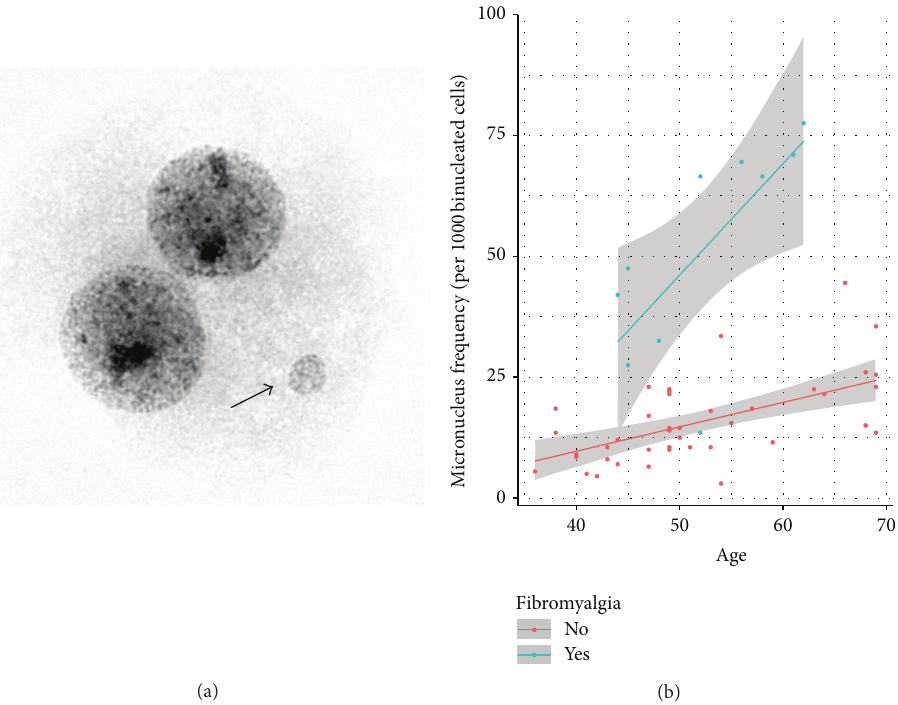
Figure 1: Increased frequency of micronuclei (MN) in women with FM. (a) A representative cell blocked at the cytokinesis phase of mitosis is shown. Karyokinesis has been completed, resulting in 2 daughter binucleates having a single MN (arrow). (b) The frequency of MN ( 𝑦 -axis) showed the expected age-related increase (age on 𝑥 -axis) for both controls (Spearman’s rho = 0.579) and patients having FM (Spearman’s rho = 0.717). The least squares regression line with corresponding 95% confidence interval (grey region) is shown for each group. After controlling for age effects, the frequencies of MN were found to be significantly higher in the women with FM compared to healthy controls ( 𝑃 = 1.49 × 10 −11